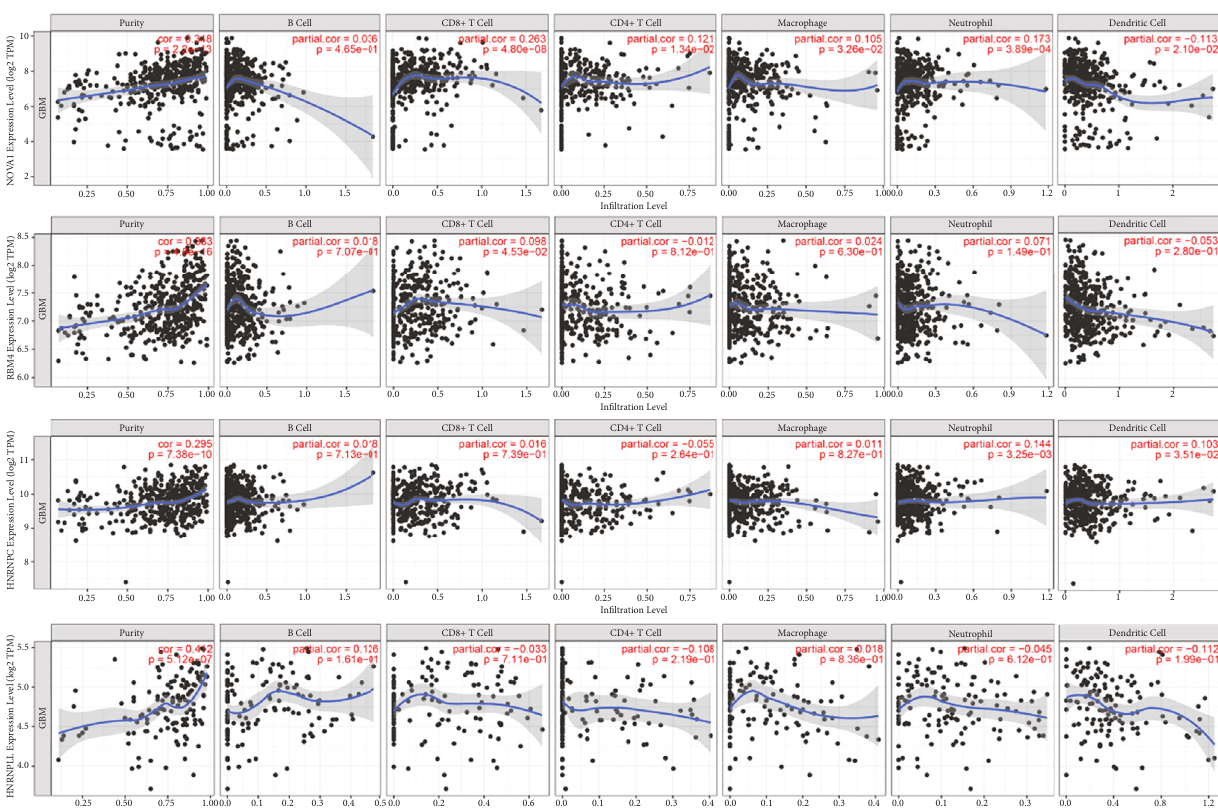
Figure 7: The correlation analysis between the expression of four SFs and immune cell in fi ltration in glioma based on the TIMER